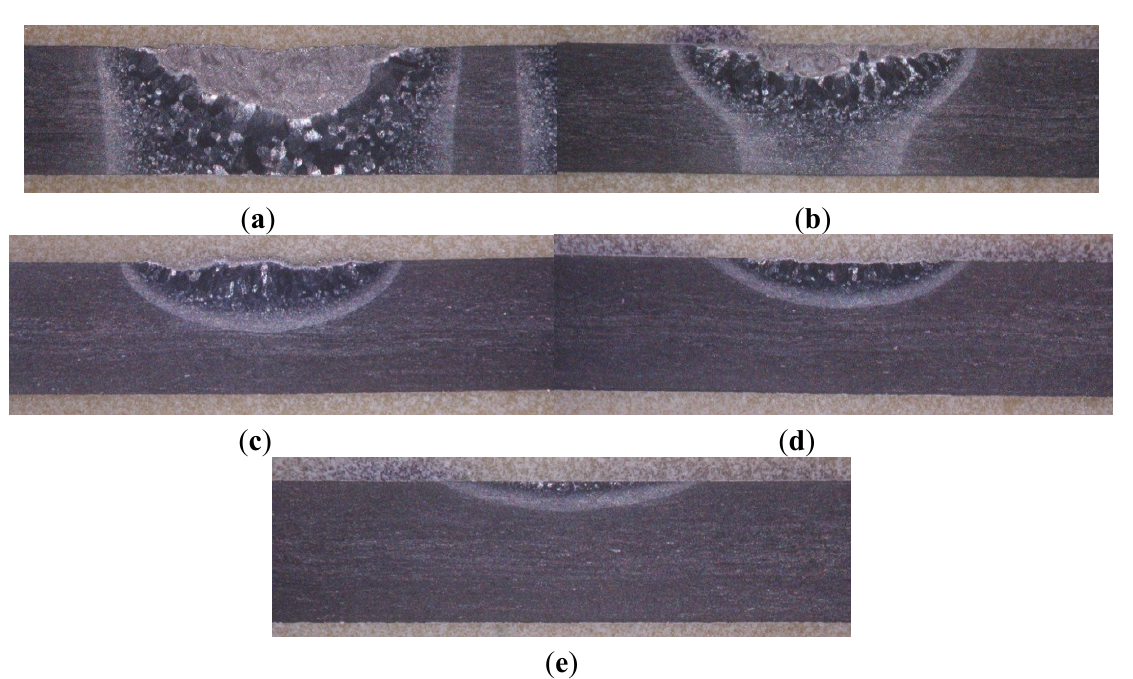
Figure 9. A view of cross-sections of surface layers after laser gas nitriding of titanium alloy Ti6Al4V by the HPDDL laser (Table 2); ( a ) sample No. P16; ( b ) sample No. P4; ( c ) sample No. P12; ( d ) sample No. P20; ( e ) sample No.